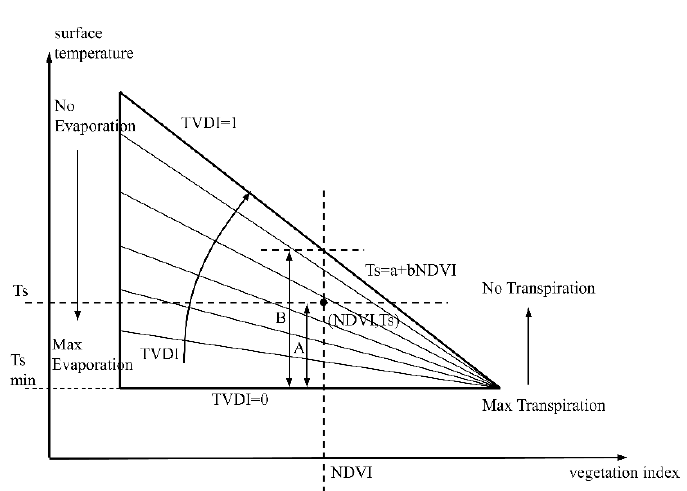
Figure 5. The sketch map of the TVDI. TVDI is established in the two-dimensional space of NDVI and LST, and the TVDI value is defined as the ratio of the distance from the pixel to the wet edge (A) to the distance between the dry and wet edges (B). [46].